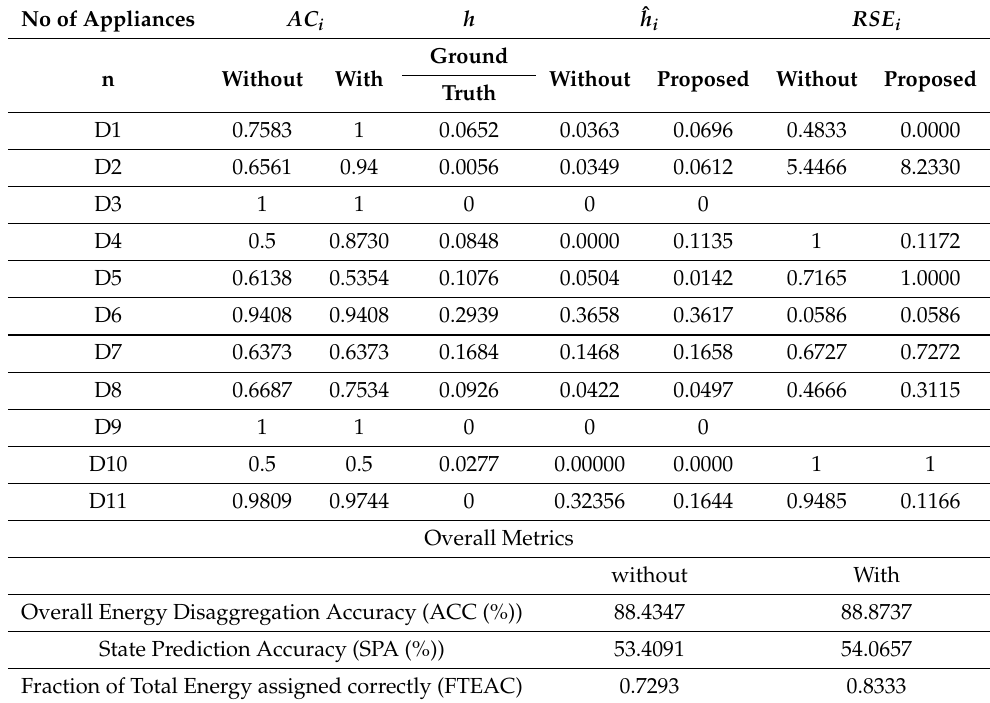
Table 4. Effect of appliance-specific constraints on the performance of energy disaggregation consid- ering I 18 problem